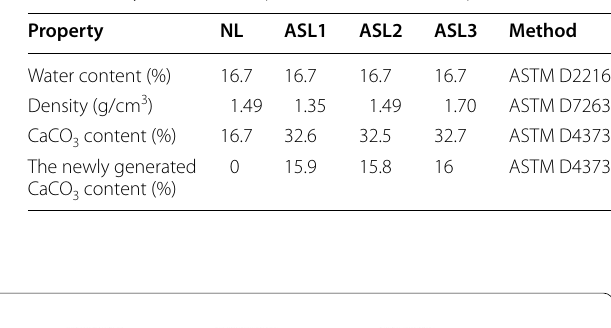
Table 1 Physicochemical parameters of the